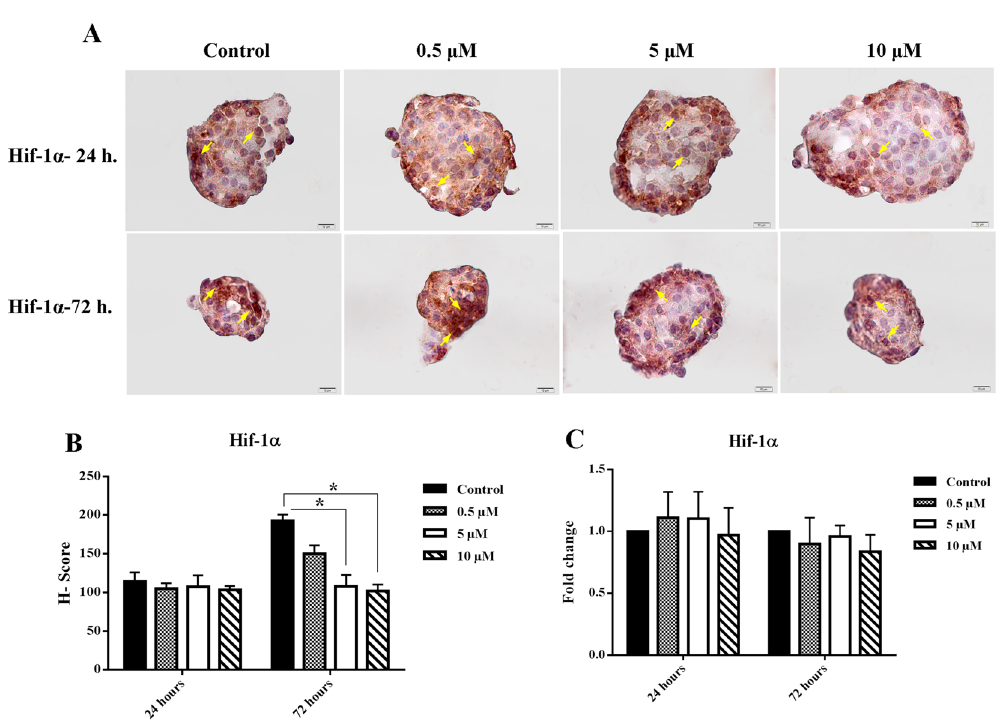
Figure 6. HIF-1 α protein and gene expression. ( A ) HIF-1 α protein expression in the different concentrations of nobiletin. The chart shows the H-score rate based on the percentage and intensity of the brown stained area in the islets (Yellow arrows show positive protein expression). ( B ) HIF-1 α gene expression in different concentrations of nobiletin. The experiment was done in triplicate from four donors and data were analyzed by Kruskal-Wallis and Post-hoc tests. Results were represented as mean ± SD. * p < 0.05. Scale bar = 10 µ